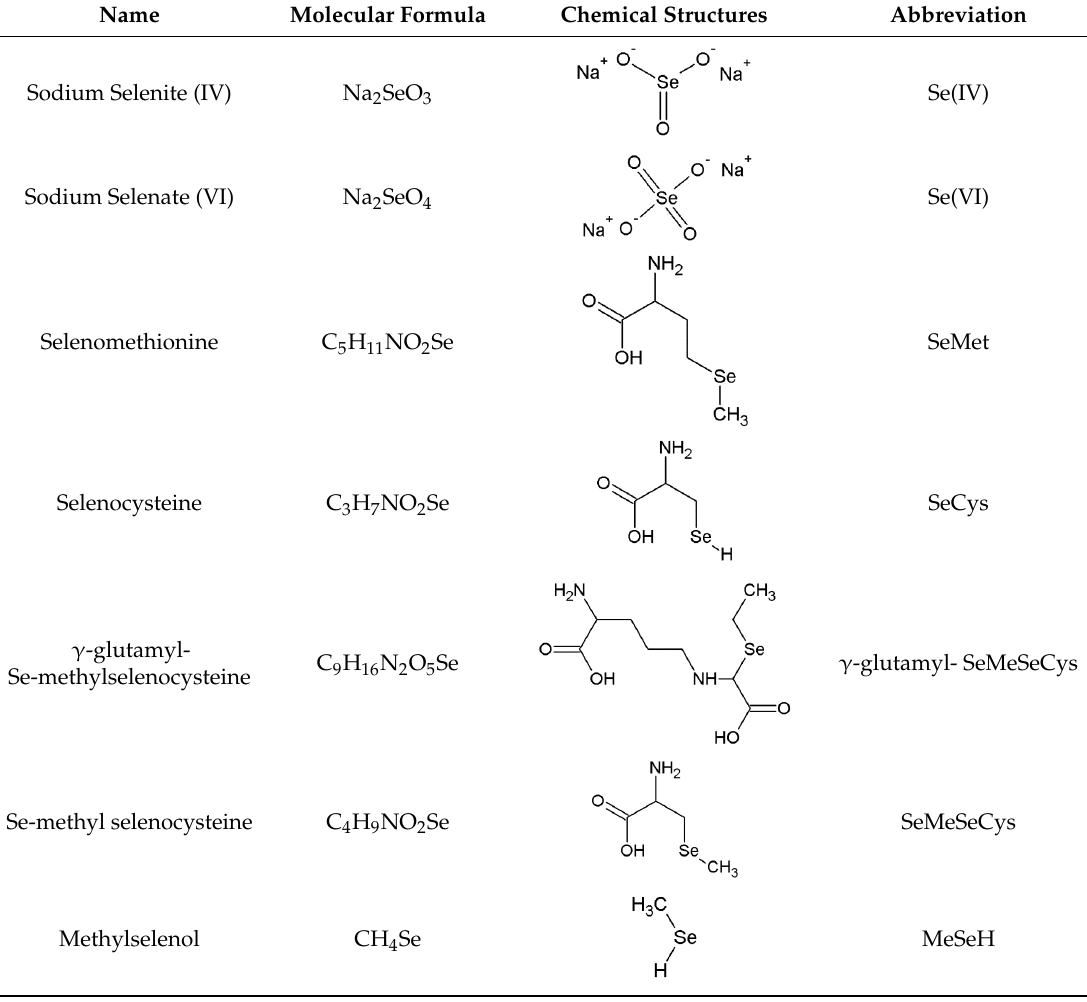
Table 2. The structures, names, molecular formula and abbreviations of Se compounds referred to in this review.